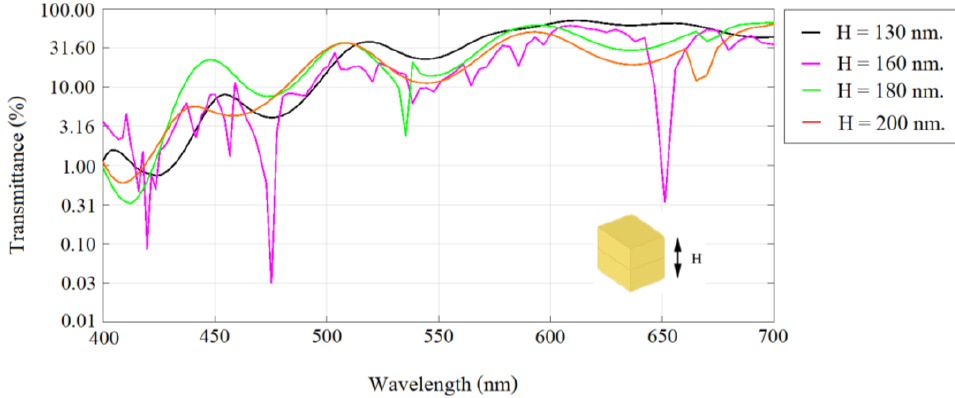
Figure 6. Transmittance when L is varied from 140 to 200 nm.